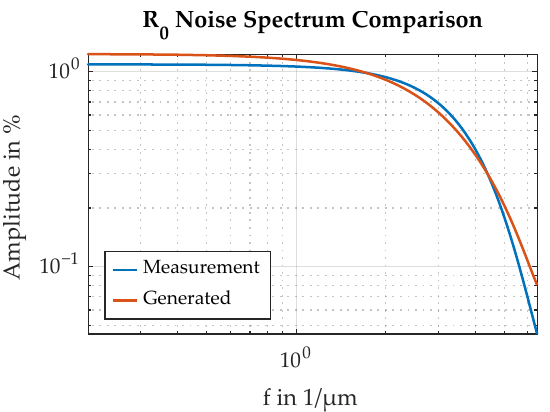
Figure 21. Spectrum of the measured deviation of reflectivity R 0 from the mean (normalized to 100%) and a generated random signal with the same standard deviation and similar spectrum.